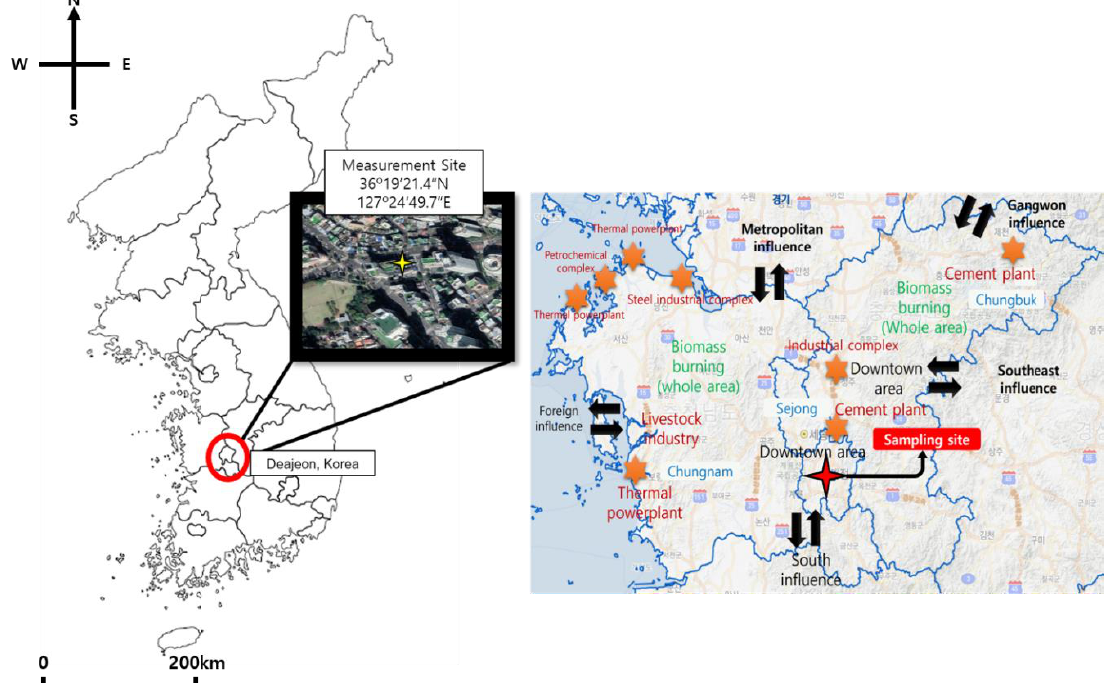
Figure 1. Location of the measurement site and surroundings.